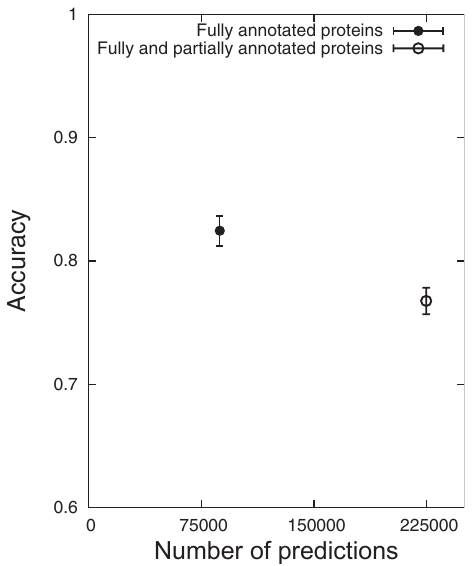
Figure 7. Accuracy and Coverage. Comparison of the number of predictions and accuracy between using, firstly, fully annotated proteins and secondly, fully and partially annotated proteins; the accuracy is the fraction of correct predictions out of all predictions against the reference set and is presented by an error bar (mean 6 2*standard deviation).